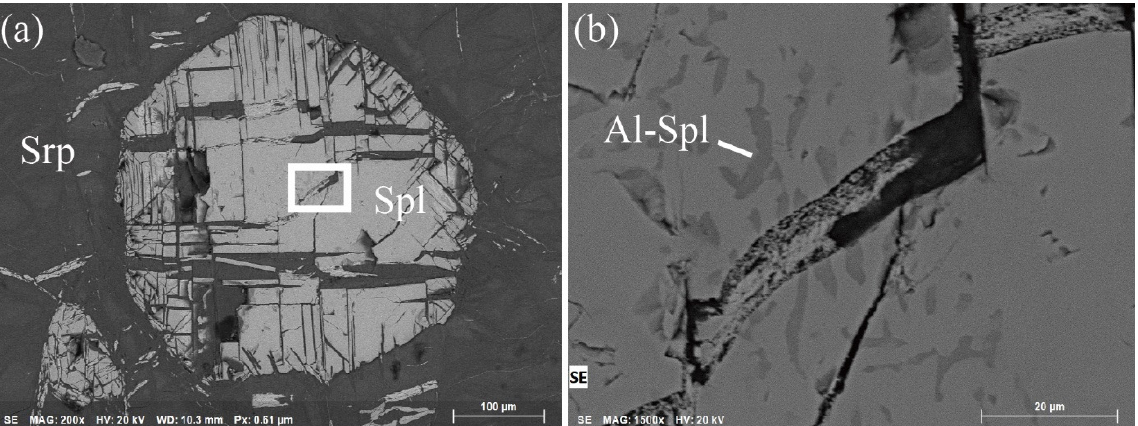
Figure 8. BSE image of type C spinel with relict Al-rich spinel ( a ); fractured type C spinel with relict Al-rich spinel ( b ).